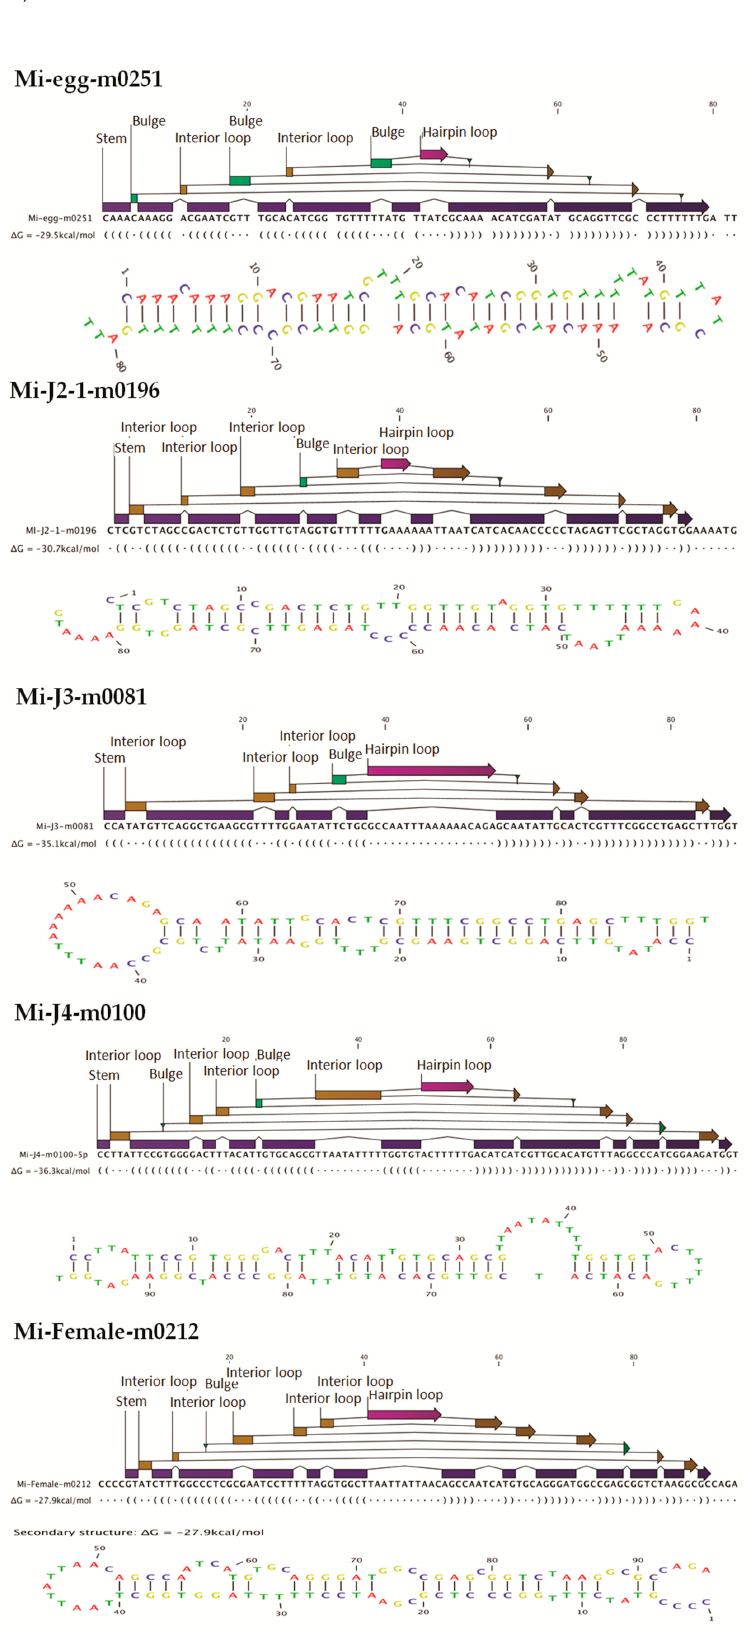
Figure 4. Pre-miRNA structure prediction of novel miRNAs from each stage of the M. incognita life cycle . Figures show structures, free energy values, and stem-loop structures for selected novel miRNAs.